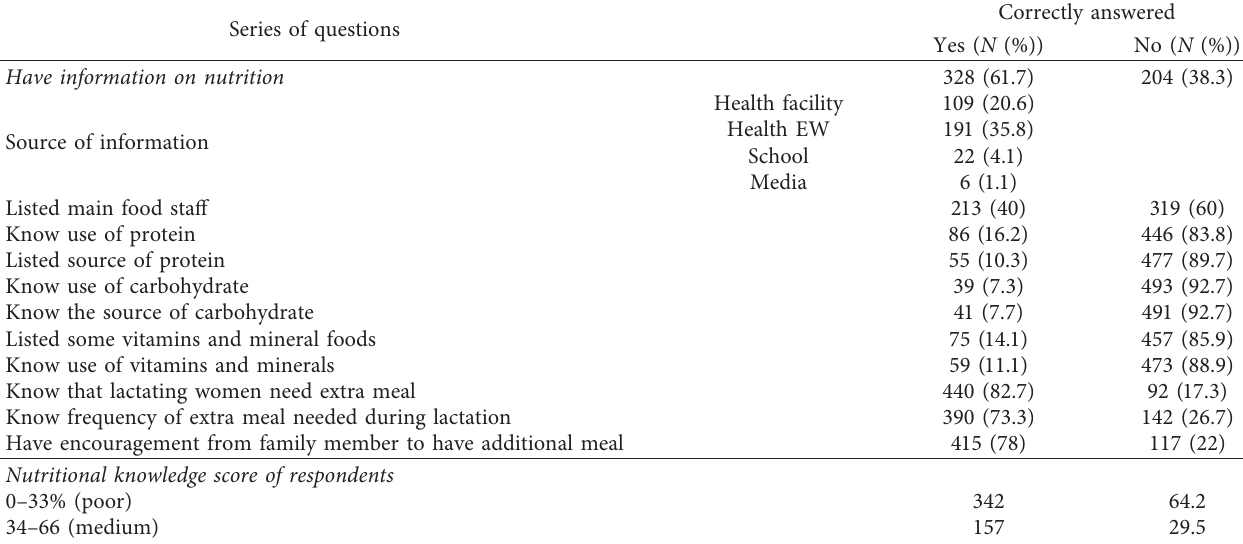
Table 4: Nutritional knowledge score of lactating women ( N � 532) in Moyale District, Borana, Southern Ethiopia, 2018. Series of questions